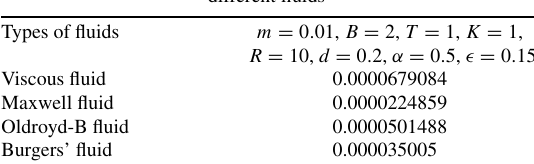
Table 1 Variation of mean-velocity distribution and reversal flow ¯ u ( y )